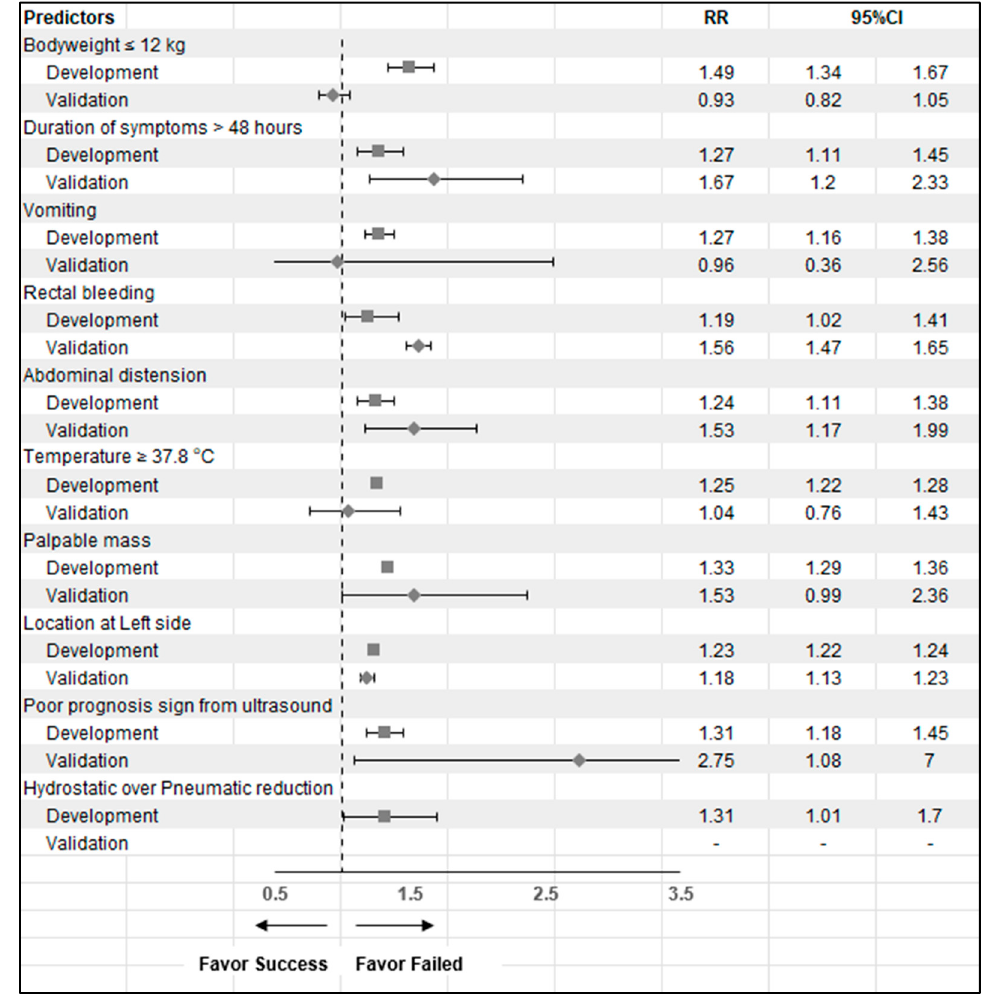
Figure 2. Risk ratio plots of the ten ‐ predictors of CMUI in the development and validation sets.